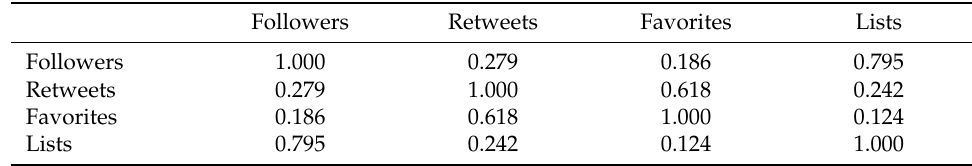
Table 4. Spearman’s Correlation between Influence